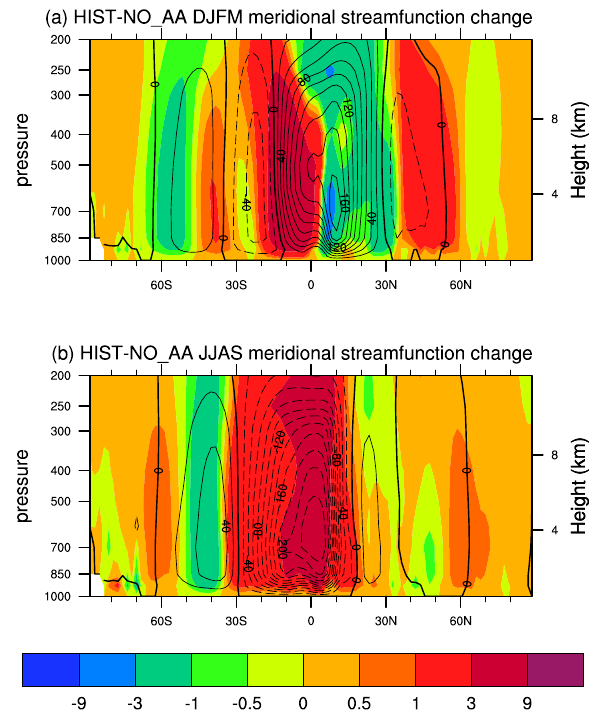
Fig. 4. Modern-day (1986–2005) minus pre-industrial (1850–1899) change in meridional streamfunction (shaded) from HIST minus NO AA for (a) DJFM, (b) JJAS. Contours show the climatology from HIST, averaged over 1850–1899. Positive numbers denote clockwise